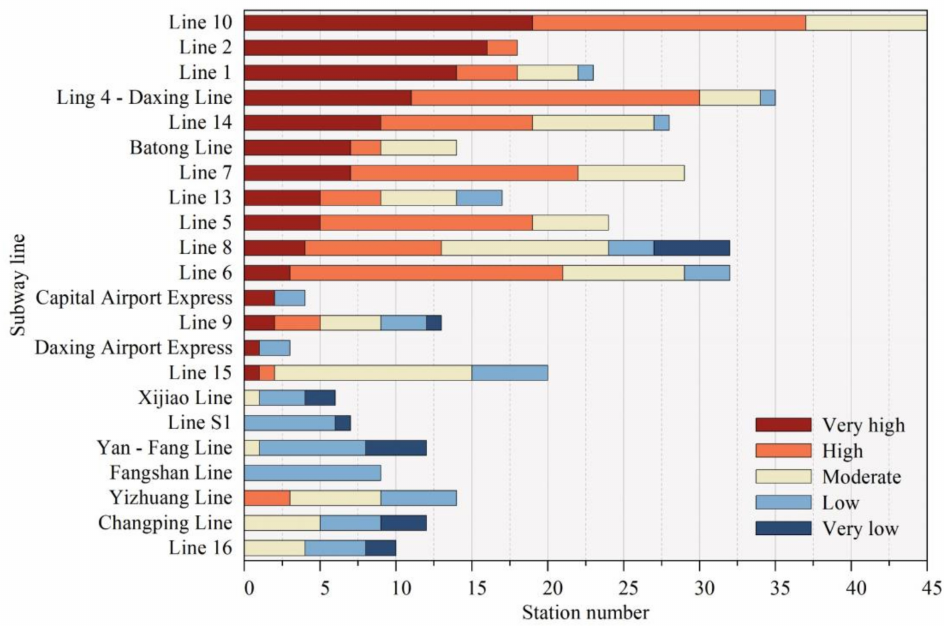
Figure 15. The number distribution of subway stations with different risk levels of each subway